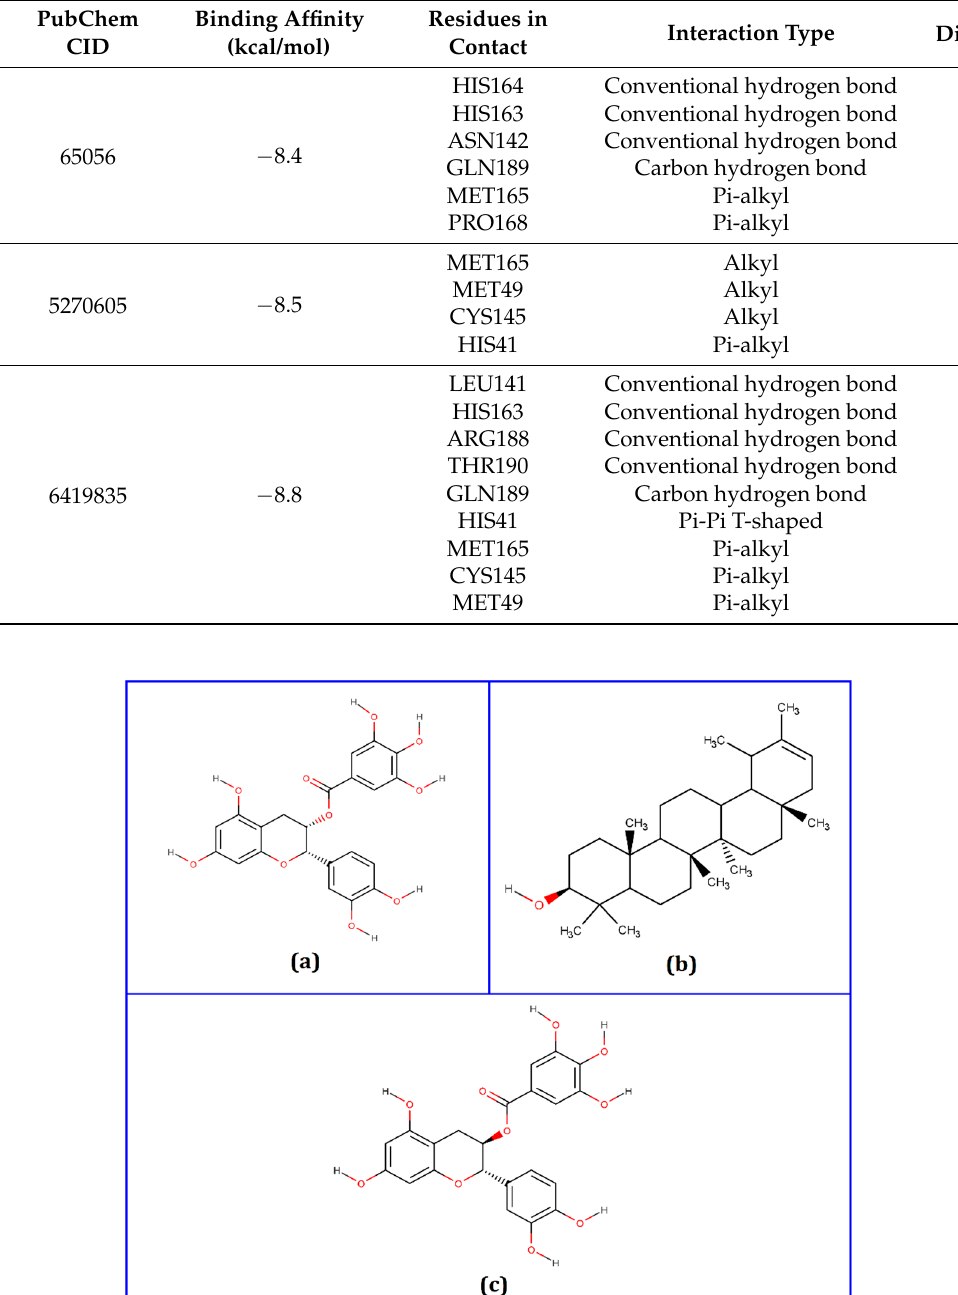
Table 1. Non-bond interactions between SARS-CoV-2 main protease and the top three (3) compounds. PubChem Binding Affinity Residues in Interaction Type Distance in Å Compounds CID (kcal/mol) Contact